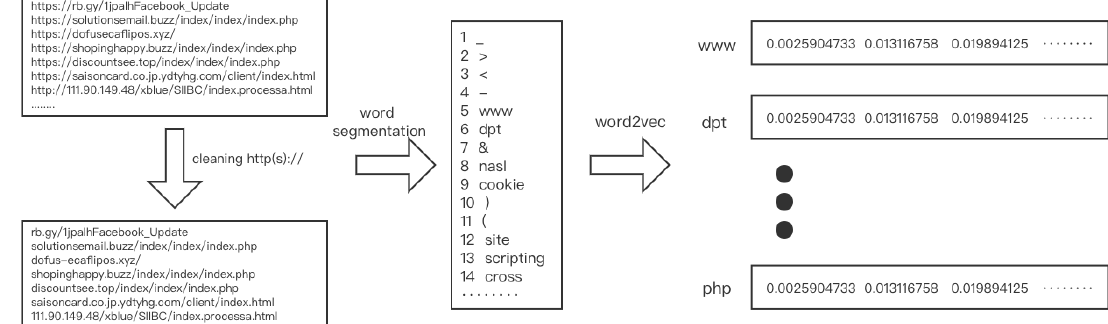
Figure 9. Flowchart of data preprocessing.